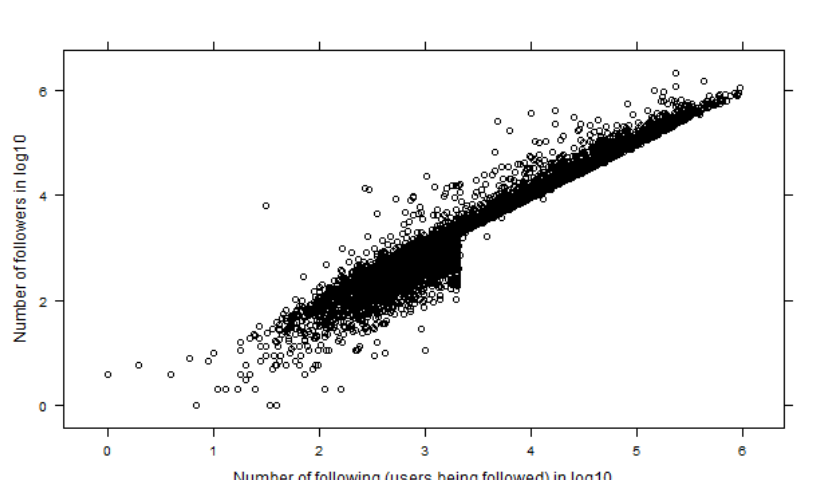
Fig. 3. Scatterplot of the number of following and followers, both values in log10 (e.g. log10(2000) = 3.3).